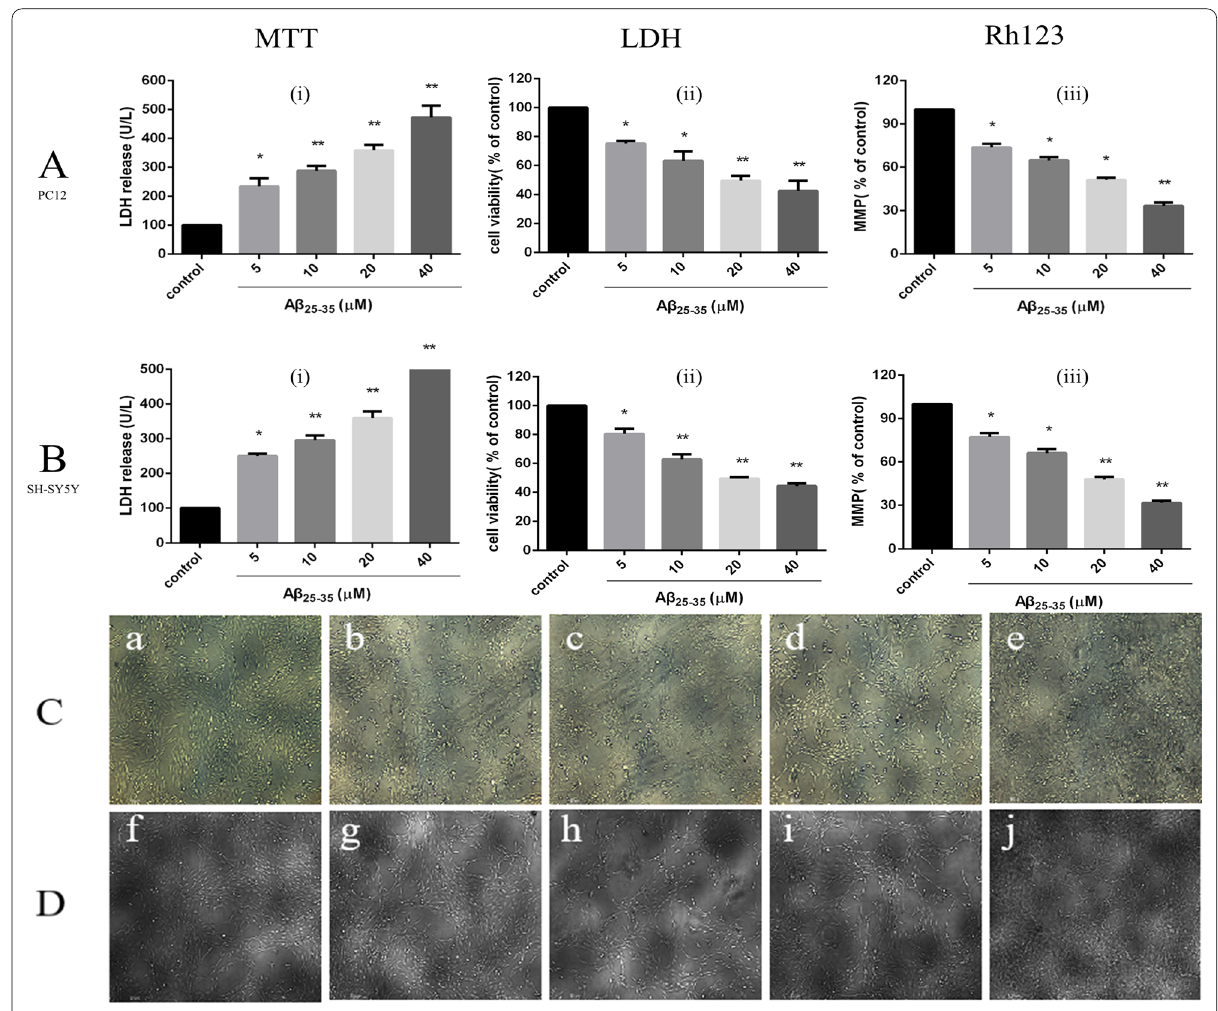
Fig. 8 Effects of different concentrations of Aβ 25–35 on injury to PC12 and SH-SY5Y cells. a , b The effect of different concentrations of Aβ 25–35 on the cell survival rate, LDH activity and cell mitochondrial membrane potential in PC12 cells and SH-SY5Y cells (* P < 0.05, ** P < 0.01 vs control group). c The effect of different concentrations of Aβ 25 – 35 on damage to the morphology of PC12 cells: a control group, b Aβ 25 – 35 (5 μM) injury group, c